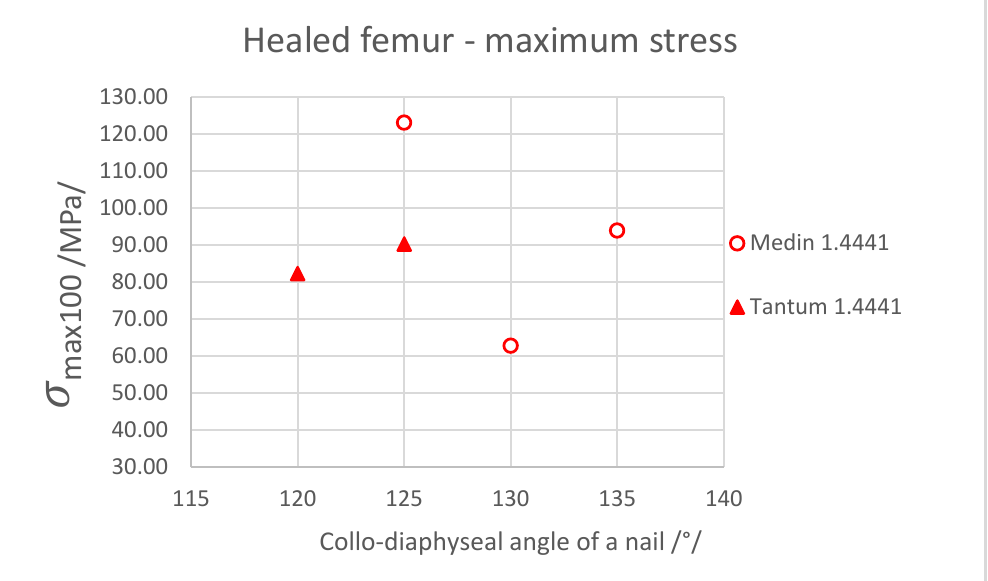
Figure 16. Dependence of maximum HMH stress (MPa) on nail collo-diaphyseal angle (healed femur).